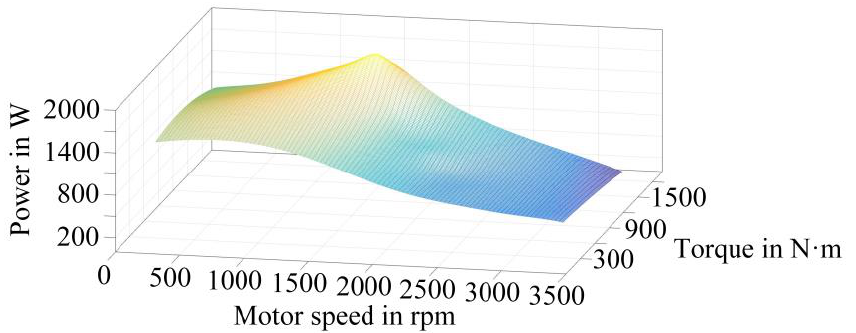
Figure 5. Power loss-speed-torque data space of IGBT.